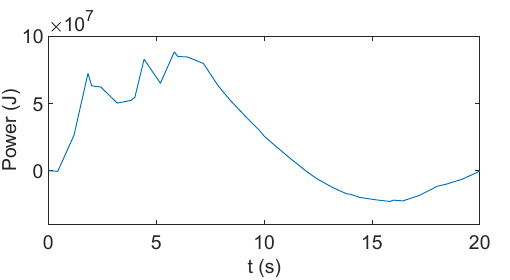
Figure 12. Power generation during the production and consumption stages.